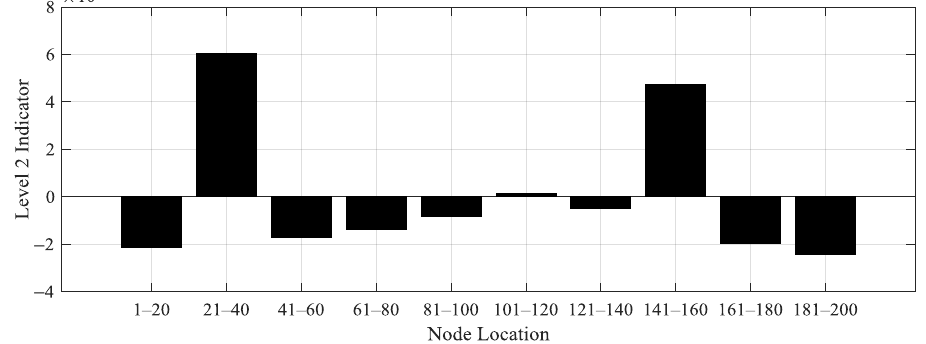
Figure 24. Level 2 damage indicator for Case 5.